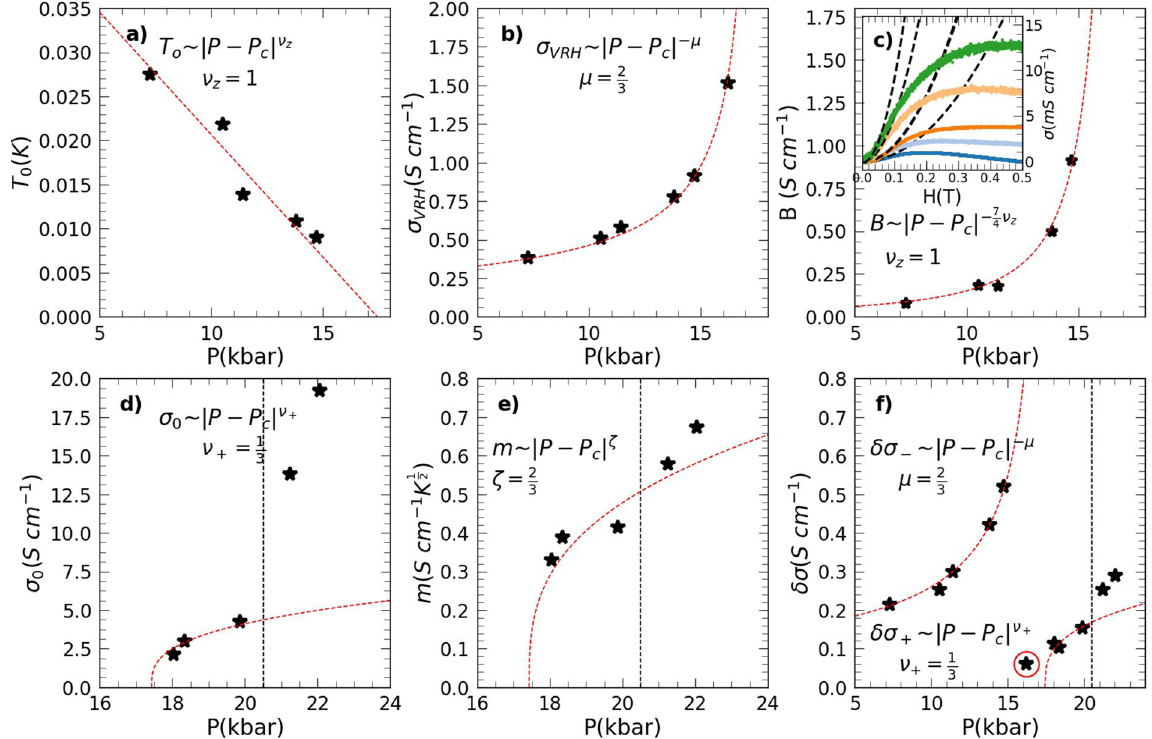
Fig. 2 Characteristic physical quantities and how they either vanish or diverge. The critical pressure is determined to be P c = 17.43 kbar. The red dashed lines represent fi ts with the mentioned critical pressure and critical exponents as they come out from the theory. The black dashed line represents the hypothetical Ioffe – Regel limit. The inset in panel c shows the 2K magnetoconductance data in the insulating phase to demonstrate the parabolic behavior at very low fi elds. The data point marked with a red circle in panel f refers to the critical regime. In the critical regime δσ does not fully vanish, as due to a Fermi energy ϵ F > 0, the spin – orbit relaxation length remains fi